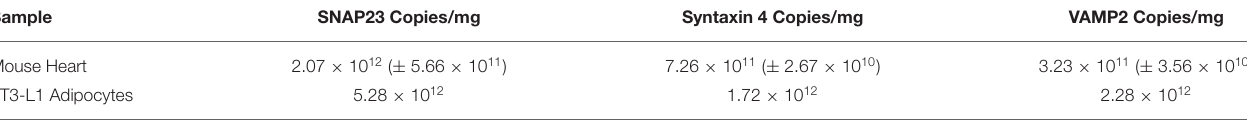
TABLE 1 | Quantification of SNARE protein expression in primary mouse cardiac tissue.